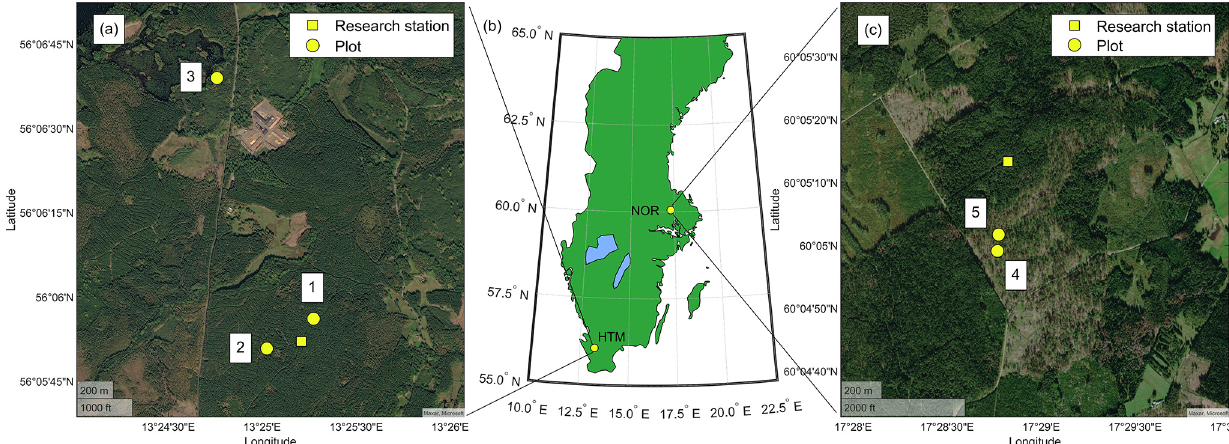
Figure 1. The location of the study site Hyltemossa (HTM; a ), the location in Sweden (b) and site Norunda (NOR; c ). Measurement plots (yellow circle) at HTM (1–3) and NOR (4–5) are shown in the site-specific maps and their location relative to the ICOS station (yellow square). Healthy Norway spruce trees were measured in plots 1–3, and infested spruce trees were measured in plots 1, 3, 4 and 5. The figure